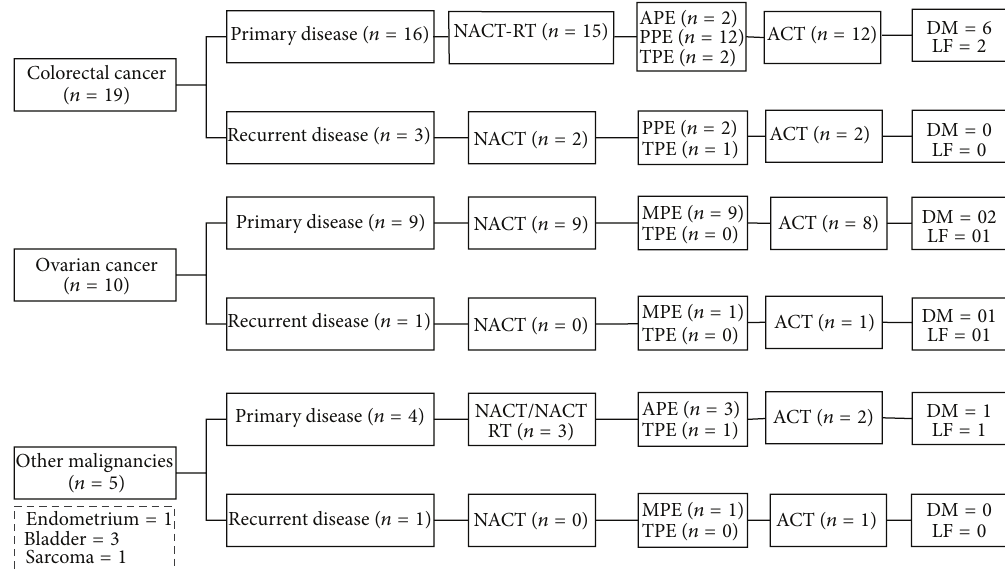
Figure 1: Consort diagram of patients. NACT: neoadjuvant chemotherapy, NACT-RT: neoadjuvant chemoradiation, APE: anterior pelvic exenteration, PPE: posterior pelvic exenteration, MPE: modified pelvic exenteration, TPE: total pelvic exenteration, ACT: adjuvant chemotherapy, LF: local failure, and DF: distant failure.